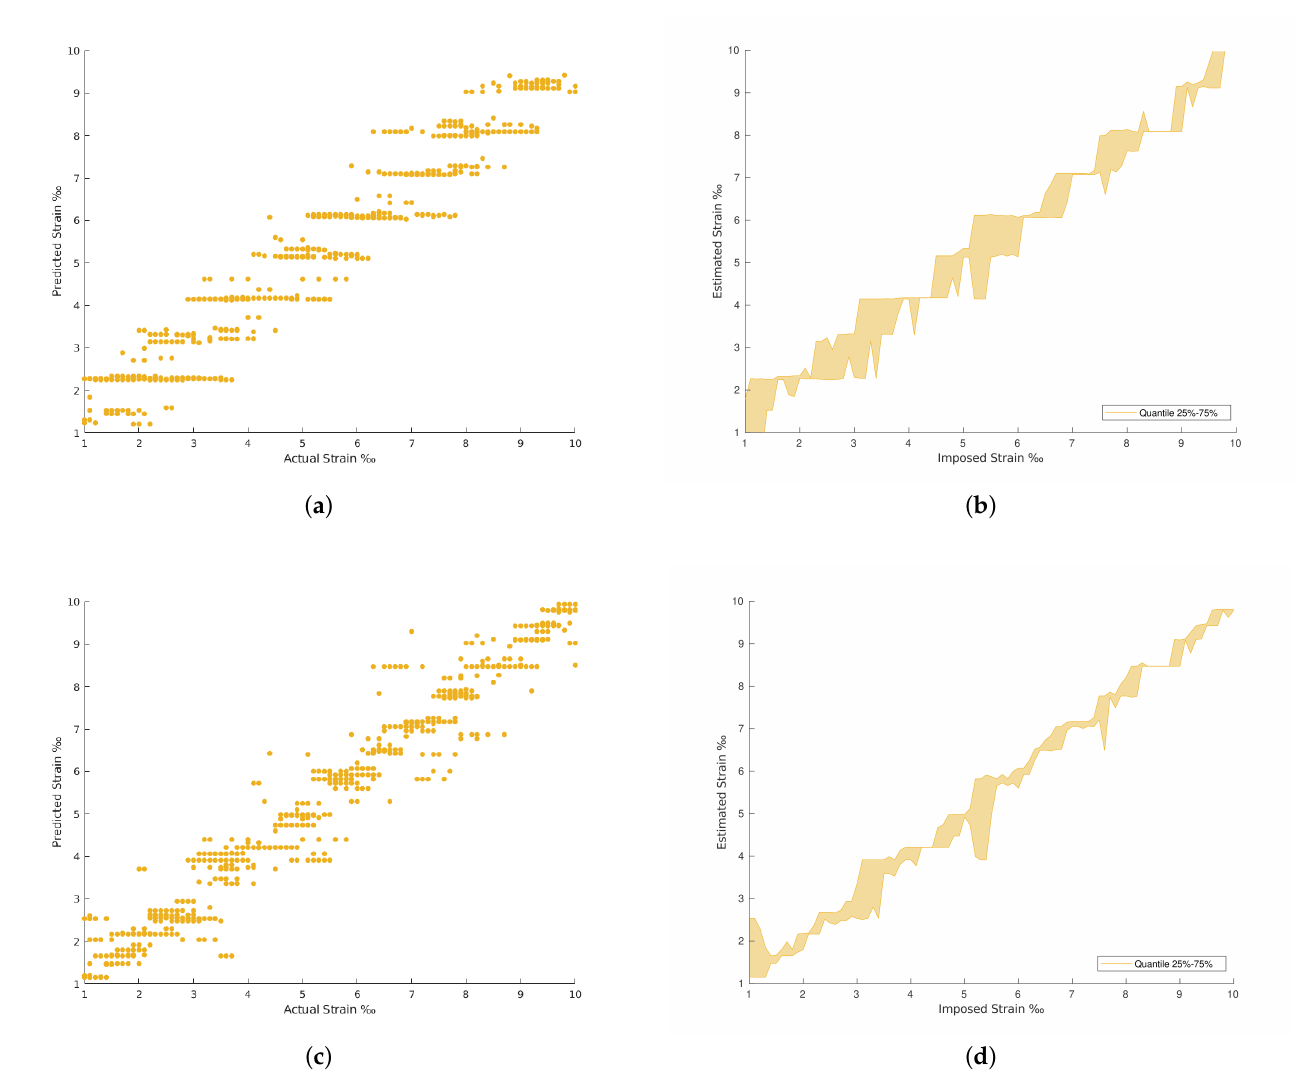
Figure 9. Polynomial Regression and Decision Tree Regression results. ( a ) Polynomial Regression pre- dictions. ( b ) Polynomial Regression predictions by quantile variations. ( c ) Decision Tree Regression predictions. ( d ) Decision Tree Regression predictions by quantile